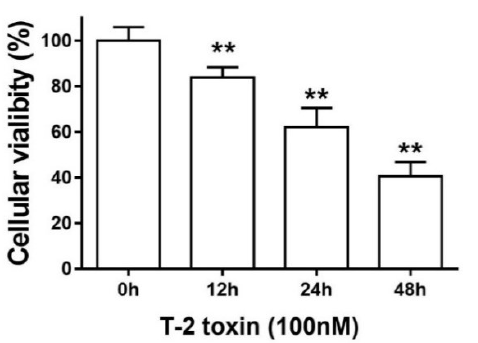
Figure 1. T-2 toxin decreases viability in TM3 cells. ** indicates p < 0.01 when compared with the untreated group. Each experiment was performed and repeated at least three times.